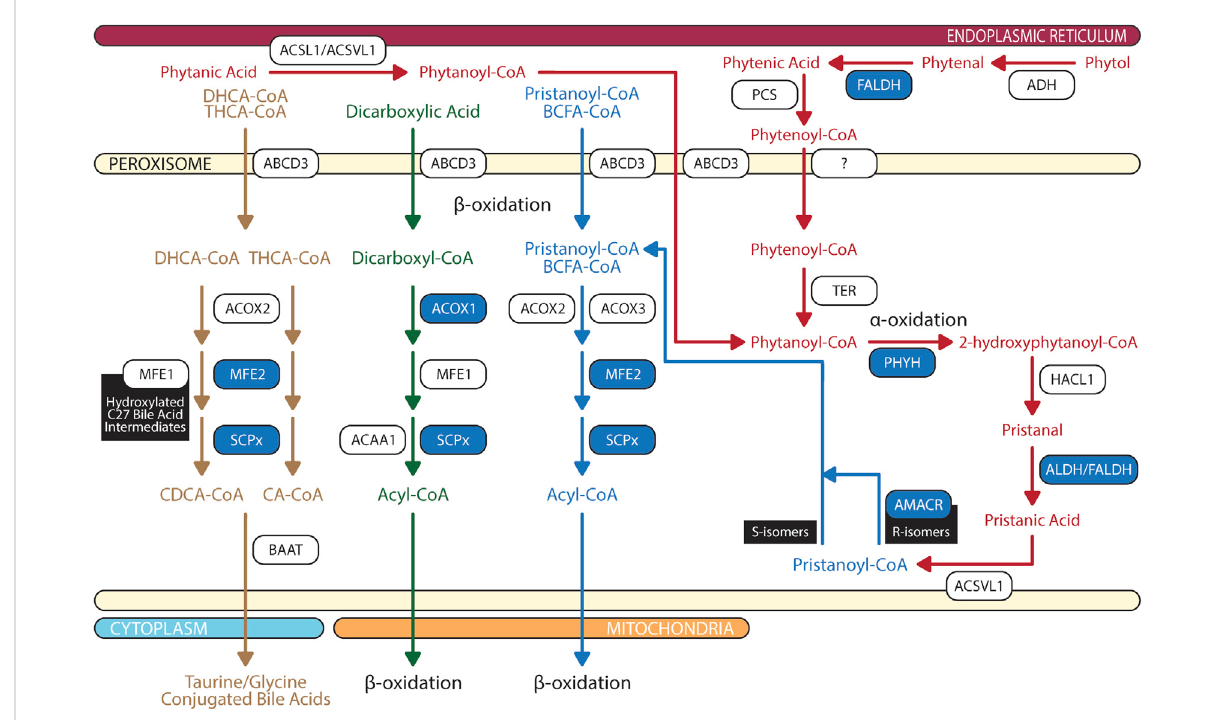
FIGURE 4 Biochemical pathways of peroxisomal branched chain fatty acid, dicarboxylic acid, and bile acid degradations. Blue box represents enzymes with published pathogenic variants resulting in ocular manifestations in humans. ABCD, ATP-binding cassette sub-family D; ACAA, 3-oxoacyl thiolase; ACOX, acyl-CoA oxidase; ADH, alcohol dehydrogenase; ALDH, aldehyde dehydrogenase; AMACR, α -methylacyl-CoA racemase; AspAT, aspartate aminotransferase; BAAT, bile acid-CoA:amino acid N-acyltransferase; BCFA, branched chain fatty acids; CA, cholic acid; CDCA, chenodeoxycholic acid; DHCA, 3 α ,7 α -dihydroxy-5 β -cholestanoic acid; FALDH, fatty aldehyde dehydrogenase; HACL, 2-hydroxyacyl-CoA lyase; MFE, multifuctional enzyme; PCS, phytenoyl-CoA synthetase; PHYH, phytanoyl-CoA 2-hydroxylase; SCPx, SCP-2/3-ketoacyl-CoA thiolase; TER, trans-2-enoyl-CoA reductase; THCA, 3 α ,7 α , 12 α -trihydroxy-5 β -cholestanoic acid. The fi gure was partly generated using Servier Medical